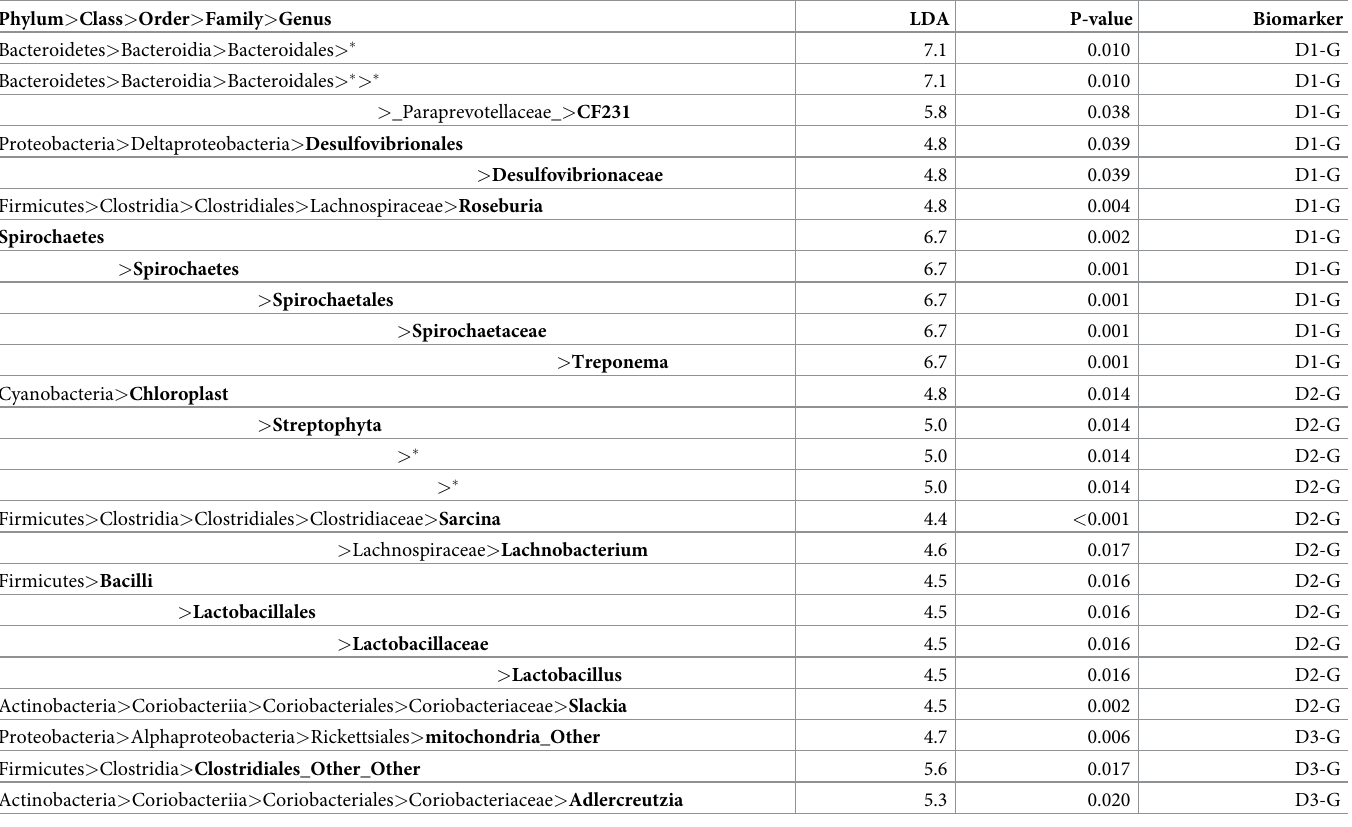
Table 2. Linear discriminate analysis effect size (LEfSe) showing significant taxa (biomarkers, in bold) in the faeces of the ponies for each sampling day (D) when ponies (n = 6) were maintained on grass (G). Phylum > Class > Order > Family >